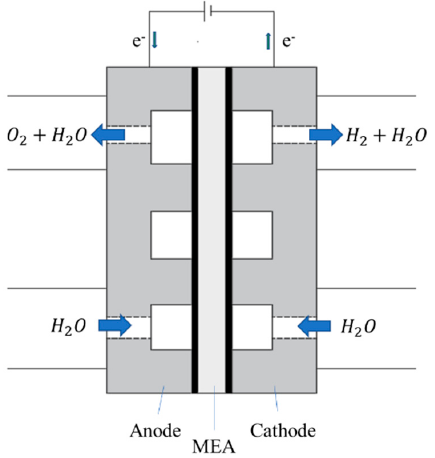
Figure 1. Schematic diagram of PEMWE working principle.